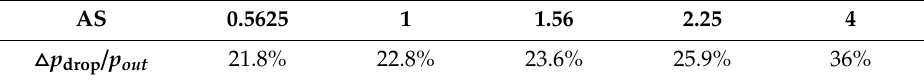
Table 5. Percentage of pressure drop to outlet pressure for di ff erent AS values.